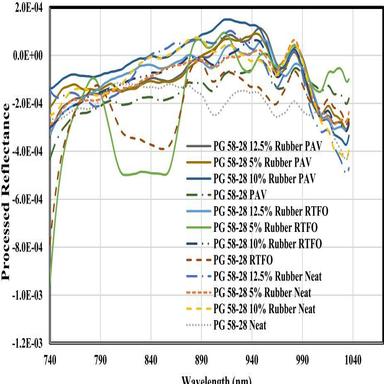
Fingerprint patterns of different PG58-28 binder.